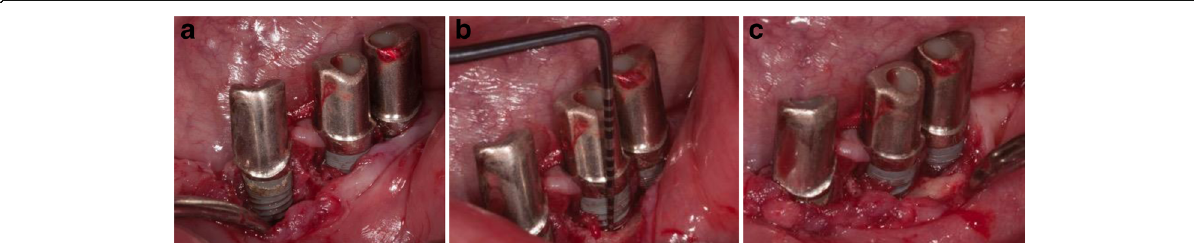
Fig. 7 a The Intraoperative situation at the implant in region 33 showed calculus and buccal crestal bone loss up to the 6th thread. b At the implant in region 34, the buccal crestal bone loss was up to the 3rd thread. The distance from the crestal bone to the abutment implant